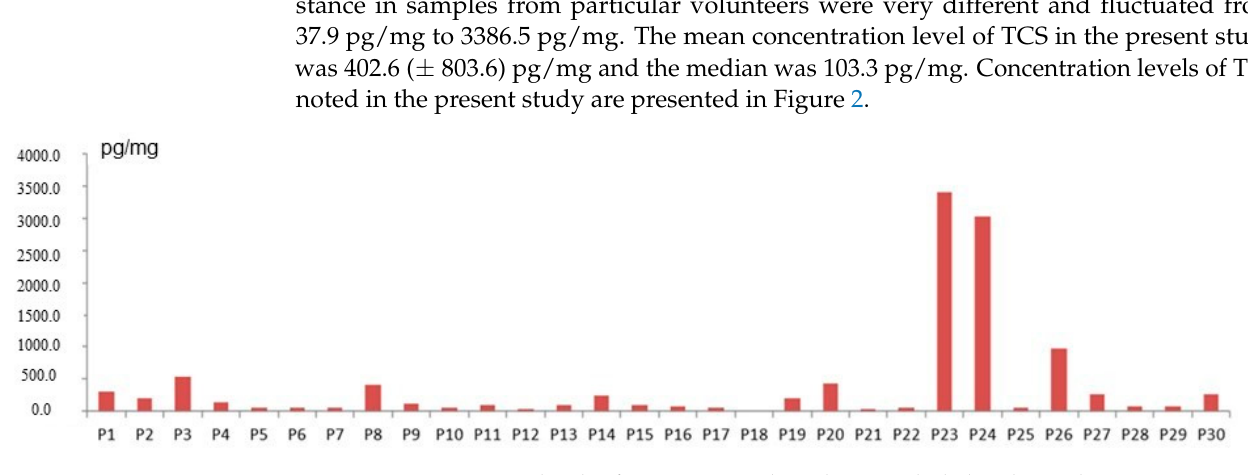
Figure 2. Concentration levels of TCS in particular subjects included in the study.